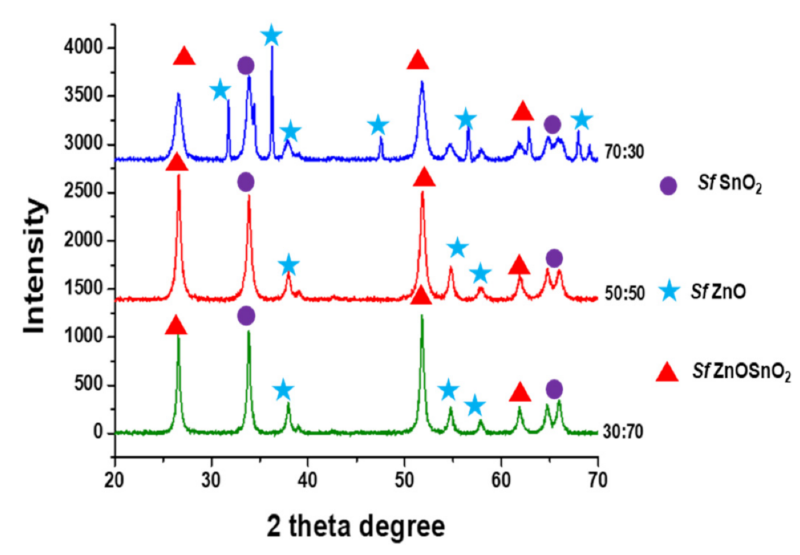
Figure 3. XRD analysis of the bimetallic nanoparticles at various